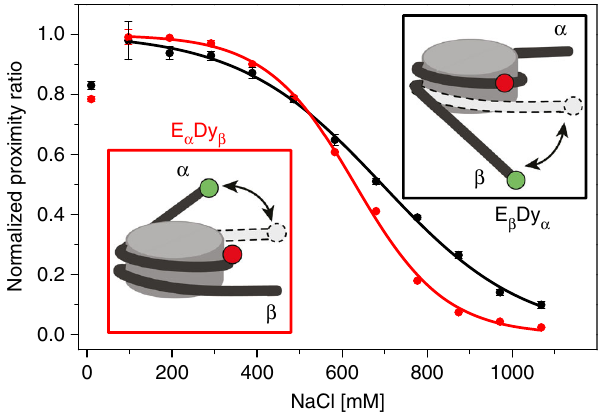
Fig. 3 Asymmetric unwrapping of DNA ends. Results of DNA unwrapping in the nucleosome constructs E α Dy β and E β Dy α (see Methods and Supplementary Note 5) studied by ensemble FRET studies. The dyes were placed at the DNA ends and near the dyad axis to report on unwrapping of each side through loss of FRET. For visualization, data were normalized to the maximal value of the proximity ratio at 100 mM NaCl and approximated by a sigmoidal function (Supplementary Note 5, Supplementary Equation 36) to obtain the c 1/2 salt concentration. The β -side was signi fi cantly more resilient against salt-induced unwrapping than the α -side. Error bars are standard errors from three replicates